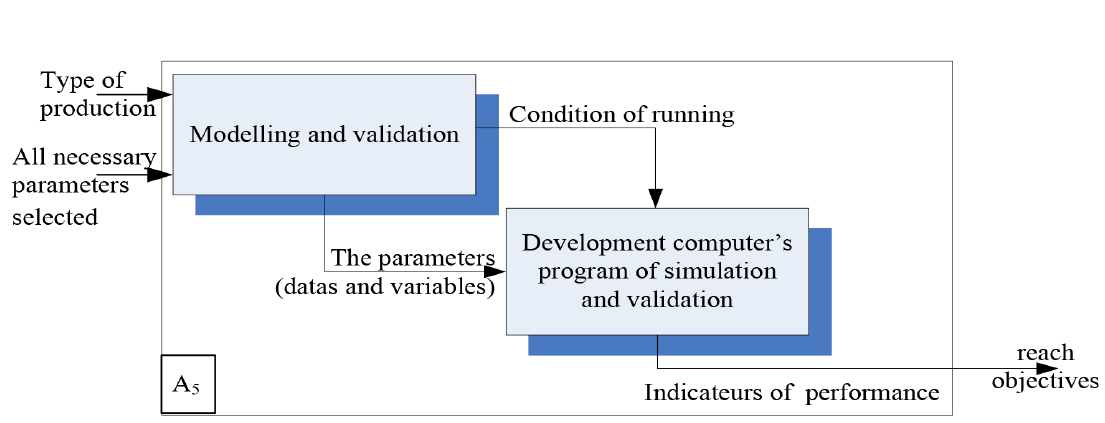
: Validation (by 5